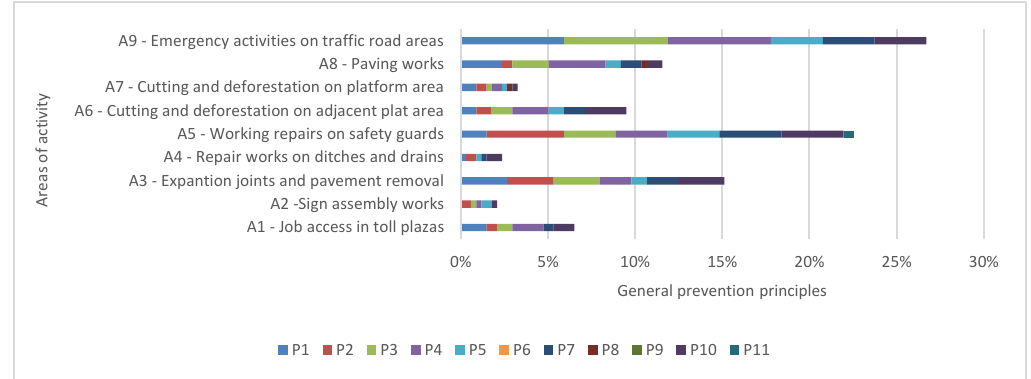
Figure 12. General prevention principles distribution associated with the most dangerous activities